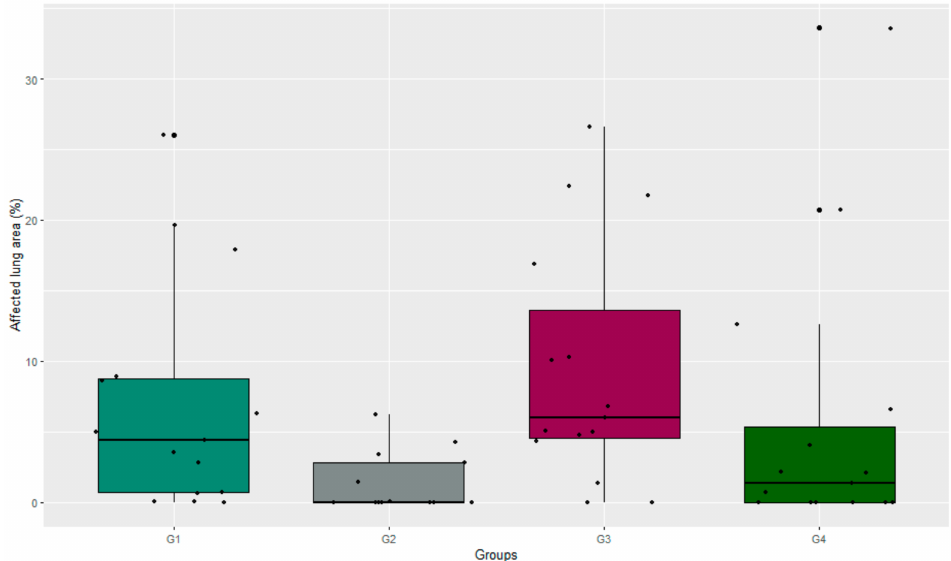
Figure 4. Boxplot demonstrating degrees of injury between groups in the macroscopic evaluation. Light dots represent each observation. The bold dots, centered on the boxplot, indicate the outliers.